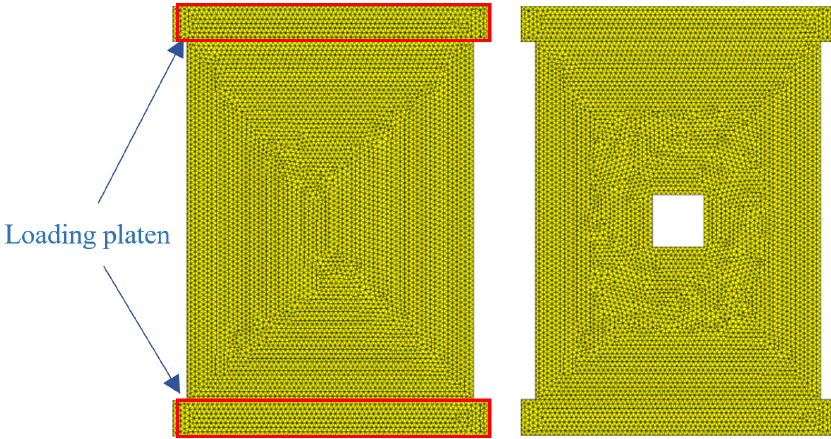
Figure 6. Two models of intact specimen and specimen with rectangle hole. Table 3. Material properties adopted in model.